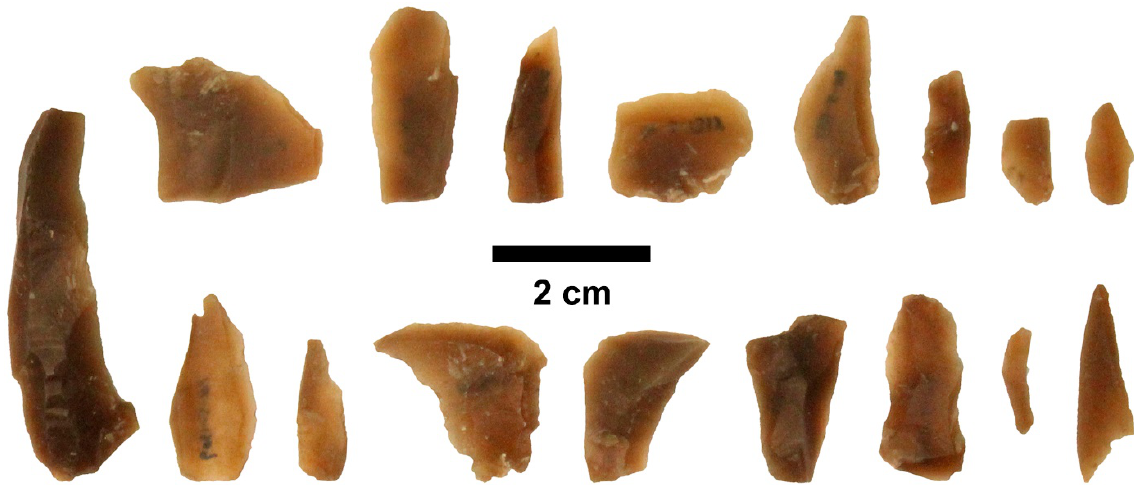
Figure 10. Translucent flint Journal of Lithic Studies (2016) vol. 3, nr. 2, p. 91-107 doi:10.2218/jls.v3i2.1872